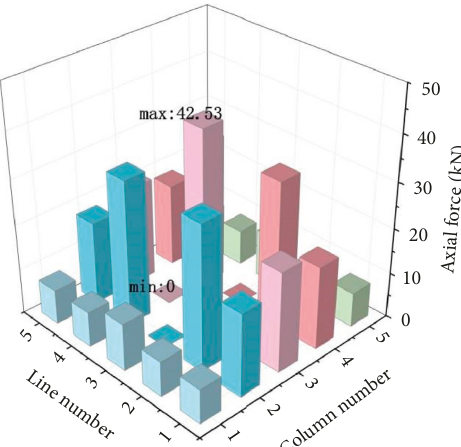
Figure 8: Schematic diagram of the axial force of 25 vertical poles when there is a installation gap of 1.4 mm at the top.